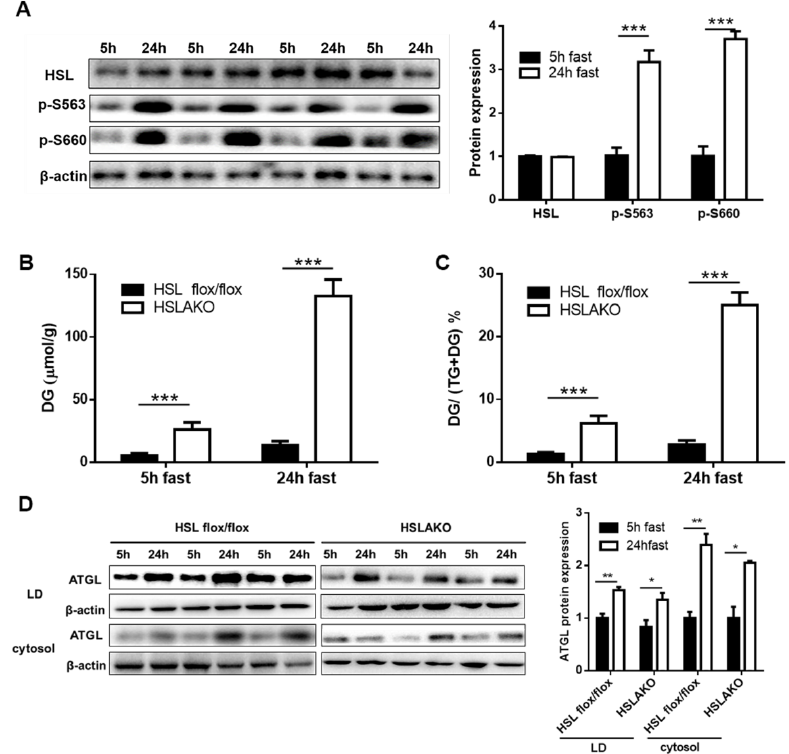
Figure 3. Levels of HSL protein, HSL phosphorylation, DG and of the DG/(TG + DG) ratio, and ATGL protein in WAT of 5-h and 24-h fasted mice. ( A ) Levels of HSL and HSL phosphorylation. Protein was extracted from WAT of wild type mice. Expression levels of total HSL, and of two phosphorylated forms of HSL, HSL-Ser563, and HSL-Ser660, were measured by Western blotting. The bar graphs show the quantification of blots from four different mice (mean ± SEM) by image J software. In each case, the level of HSL at 5 h of fasting is assigned a value of unity and the level at 24 h of fasting is expressed relative to it. ( B ) Measurement of DG content and ( C ) of the DG/(TG + DG) ratio of mouse WAT after 5 h or 24 h of fasting. ( D ) Levels of ATGL protein in the lipid droplet and cytosolic fractions of HSL flox/flox and HSLAKO mice after 5 h or 24 h of fasting were detected by Western blotting. Results were quantified from three different mice in each group. Values are mean ± S.E.M. * p < 0.05, ** p < 0.01, *** p < 0.001.